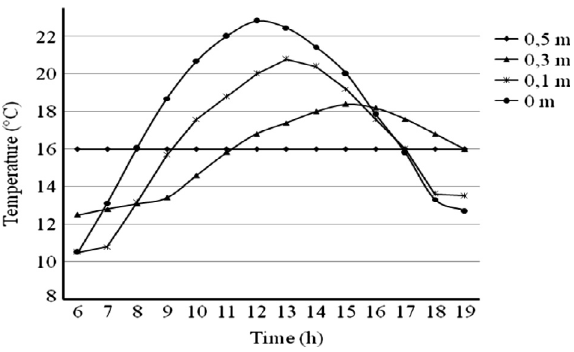
Figure 9. Horary evolution of the soil temperature (May